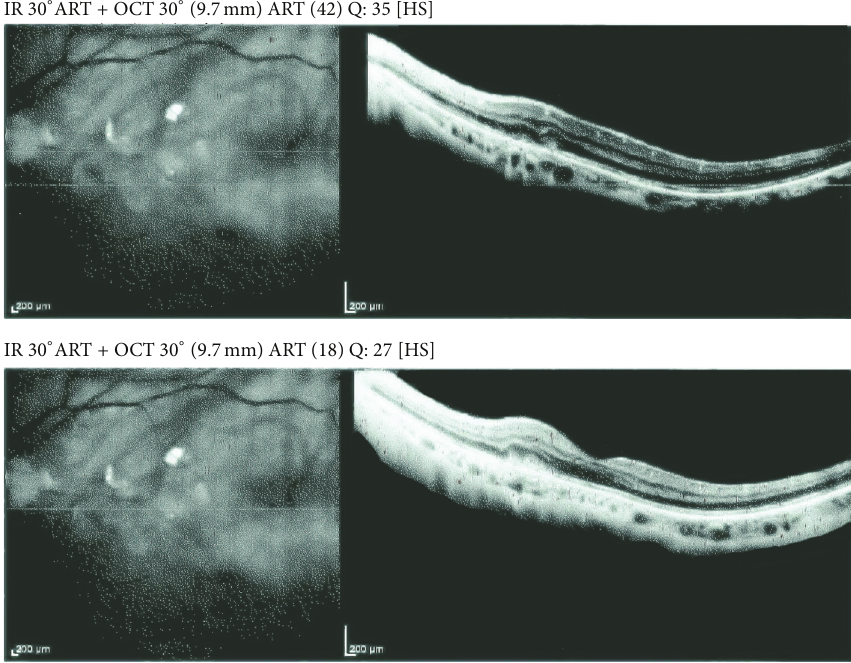
Figure 2: Evolution after hemorrhage